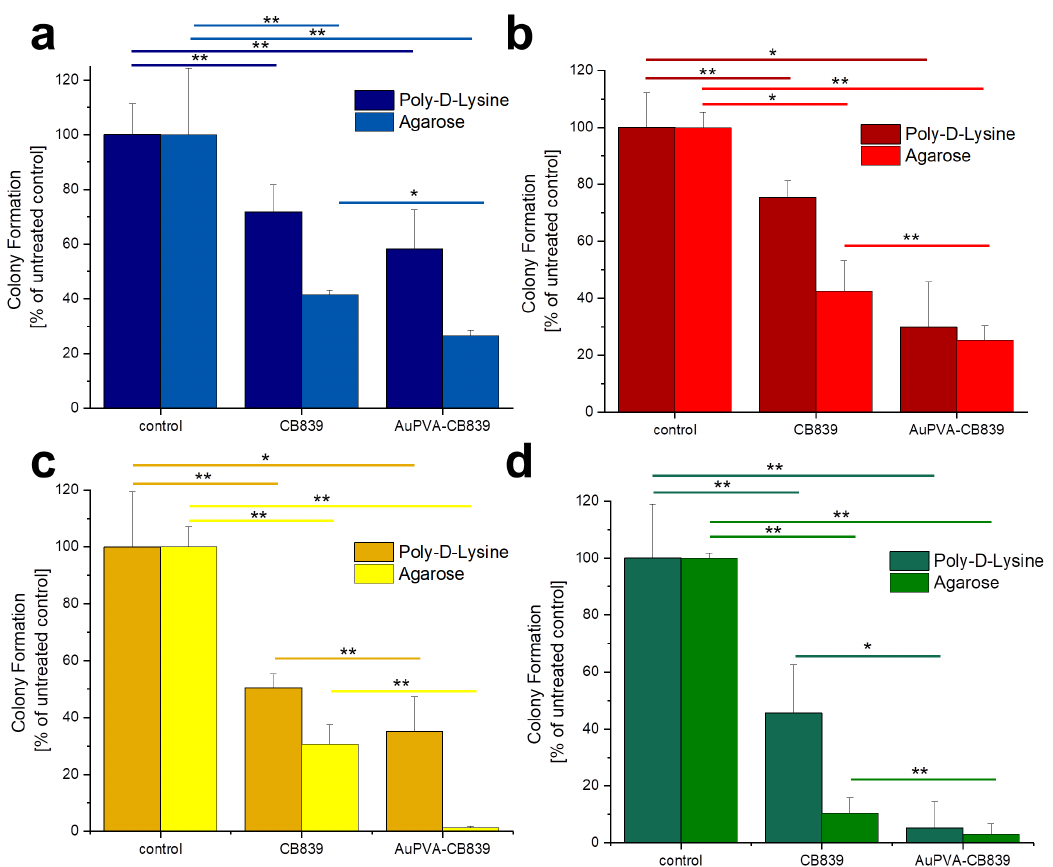
Figure 6. Colony Formation of U87 ( a ), JHH520 ( b ), GBM1 ( c ), and BTSC407 ( d ) cells after incubation with AuPVA-CB839 NPs, using both the 2D poly- D -lysine and the 3D agarose method. Dark columns in ( a ) are labelled as poly- D -lysine for comparison, even though no adhesion polymer was used since cell model U87 grows adherent already. A two-sample t-test was performed using Origin 8 software and significances are indicated: * p > 0.05, ** p > 0.03.